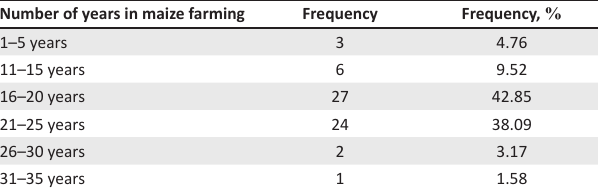
TABLE 1: Years of farming with maize around the area. Number of years in maize farming